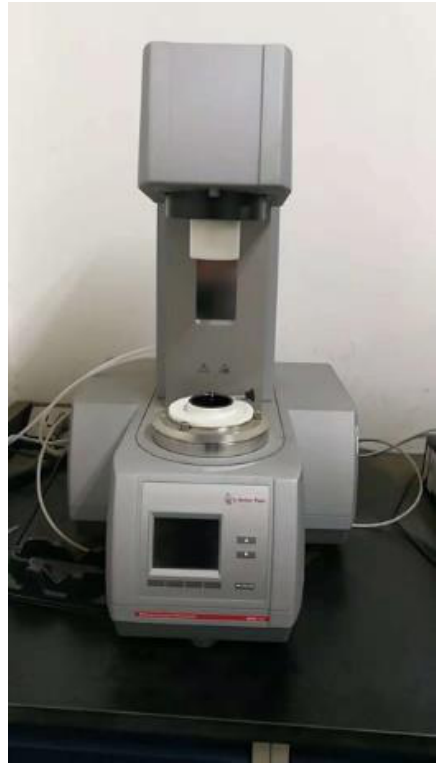
Figure 5. Anton Paar RheolabQC Rheometer.